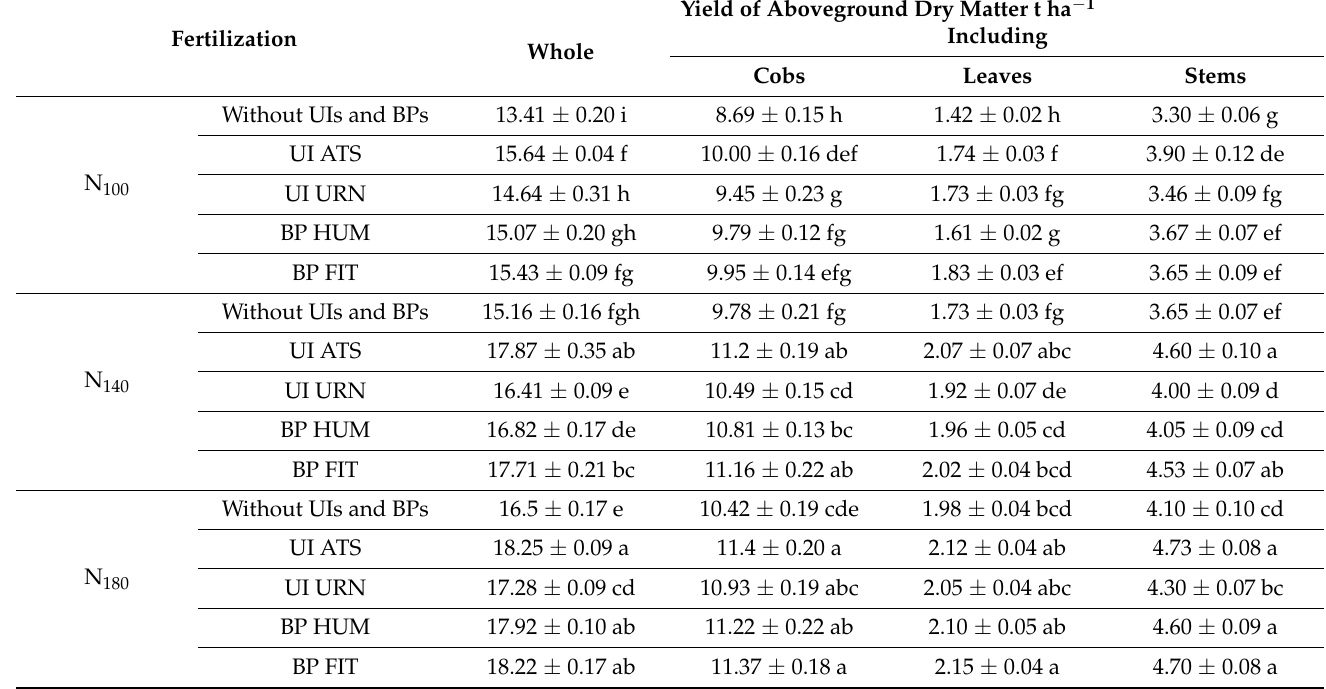
Table 8. The influence of different nitrogen fertilizer rates, urease inhibitors, and biological prepara- tions on the dry matter yield and yield structure of maize in